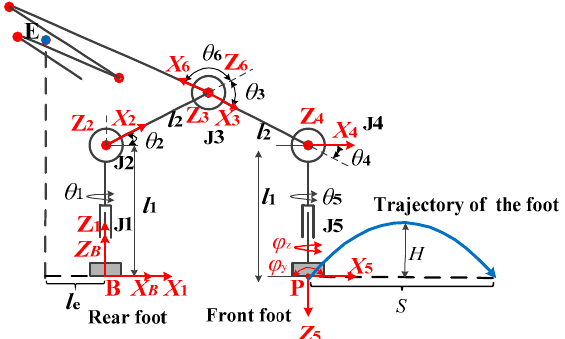
Figure 10. Kinematic model of the climbing mechanism.